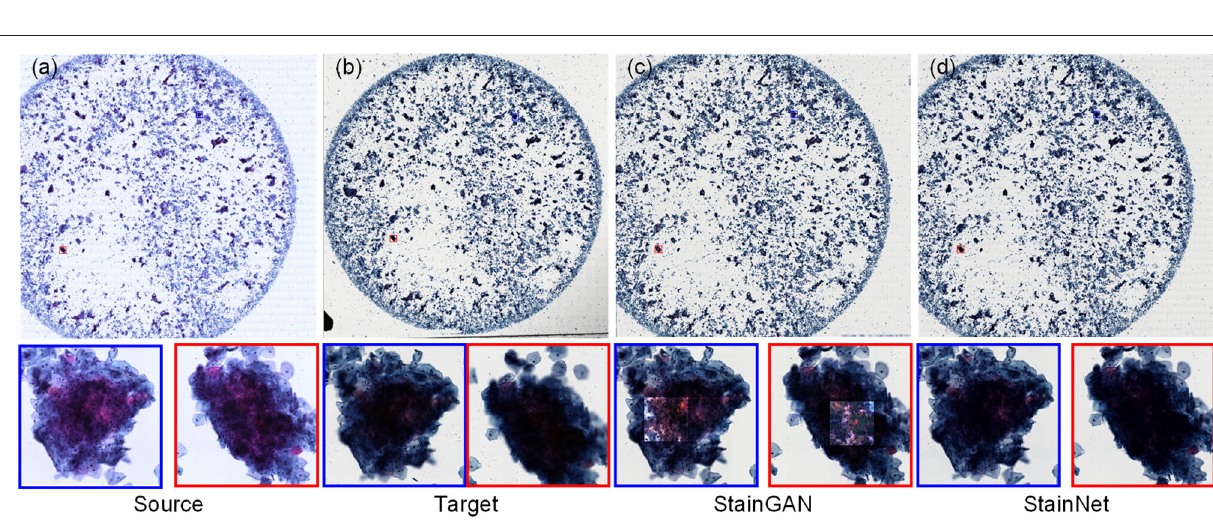
color distribution with the target images. In terms of local